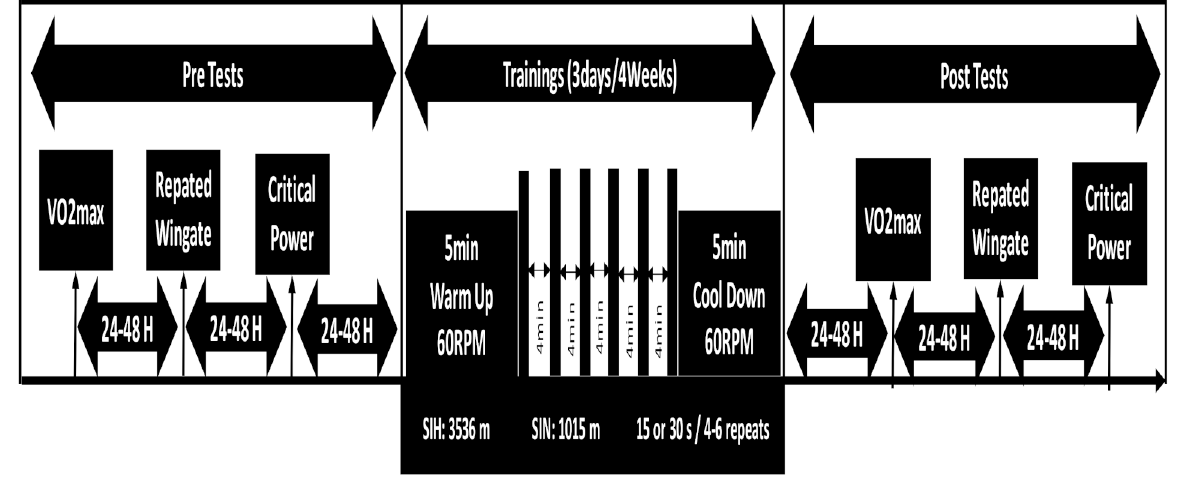
Figure 1. Schematic diagram of the study summary.